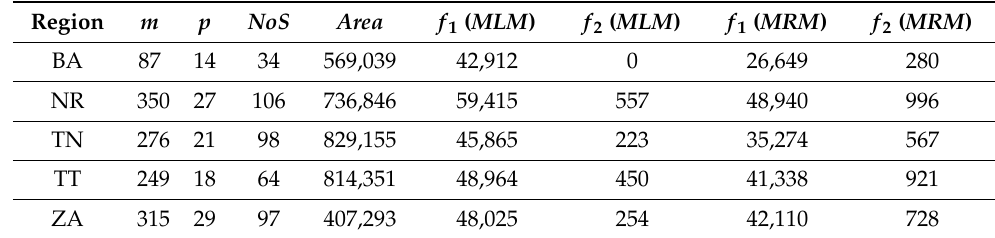
Basic studied properties of used benchmarks and the exact Pareto fronts of non- dominated